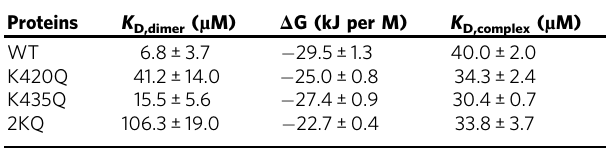
Table 1 Equilibrium constant of p62-UBA dimer and p62-